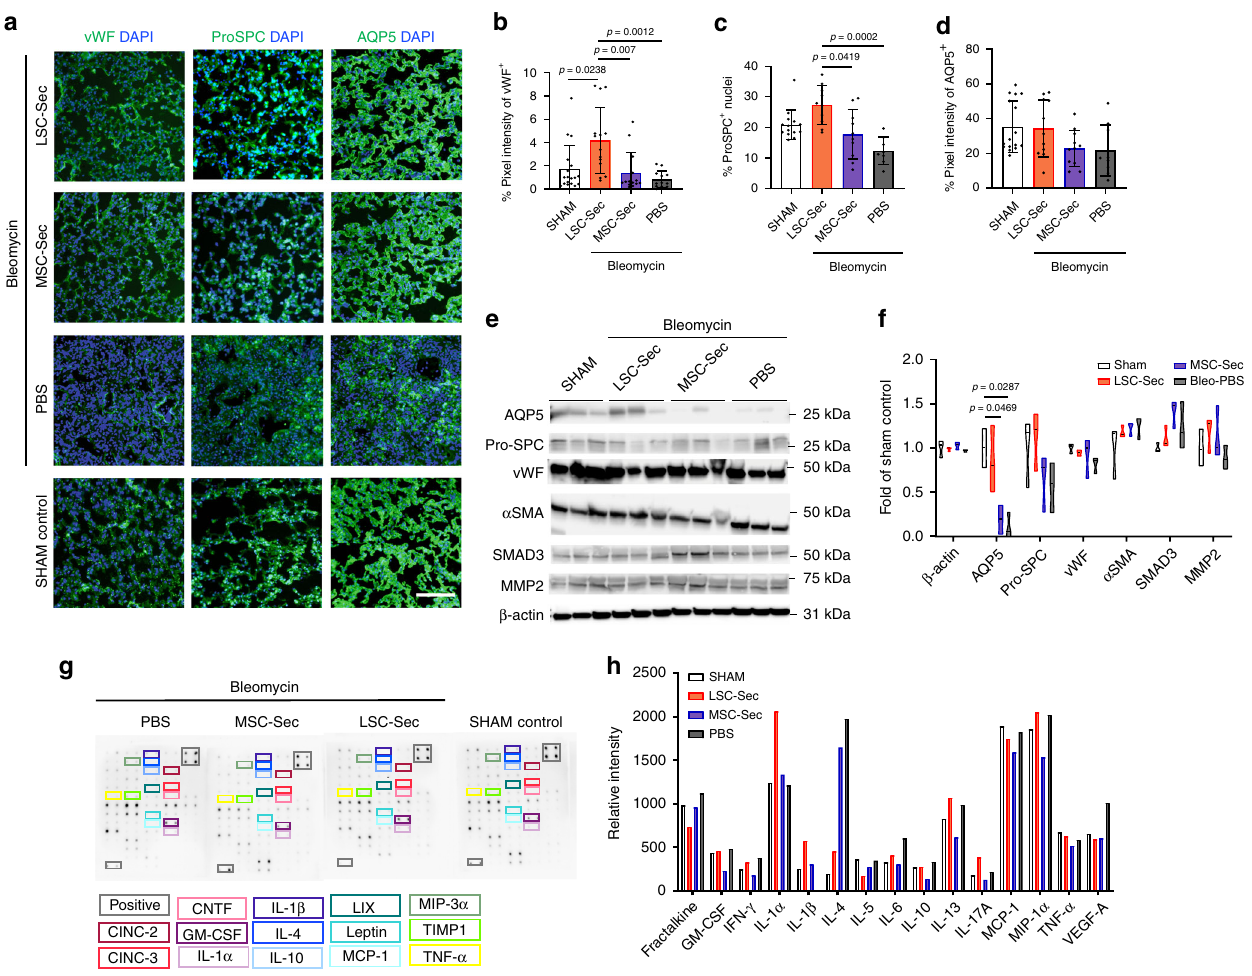
Fig. 2 LSC-Sec inhalation treatment promotes alveolar repair. a Representative immunostaining of lung sections for von Willebrand Factor (vWF), pro- surfactant protein C (Pro-SPC) and aquaporin 5 (AQP5). Scale bar = 100 μ m. b – d Quanti fi cation of percent pixel intensity of vWF + ( b ), percent ProSPC + nuclei ( c ), and percent pixel intensity of AQP5 + ( d ); each dot represents data from one animal; n = 12 biological independent animals. e – f Immunoblot analysis of aquaporin 5 (AQP5), pro-surfactant protein C (Pro-SPC), von Willebrand Factor (vWF), alpha smooth muscle actin ( α SMA), SMAD3, matrix metalloproteinase 2 (MMP-2), and beta-actin loading control (B-actin) from lung protein lysate ( e ) with corresponding quanti fi cation of protein levels as fold of sham control ( f ); each dot represents data from one animal; n = 3 biological independent animals. g – h Representative cytokine array with quanti fi cation of relative intensity ( g ) and corresponding quanti fi cation of relative intensity ( h ). Throughout, data are mean ± s.d. P -value as indicated by non-parametric one-way